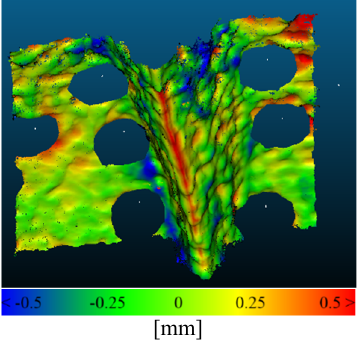
Figure 13. 3D comparison with model derived from triangulation sensor.